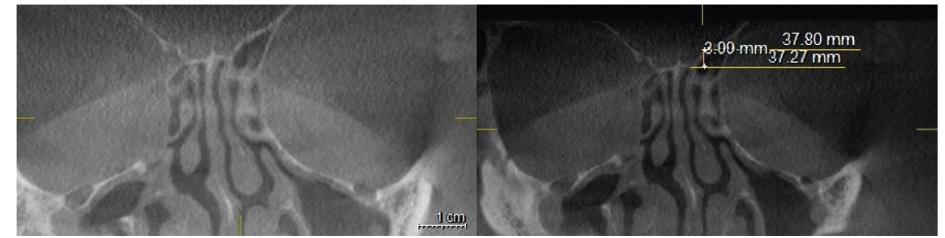
Figure 1: Coronal plan of CBCT demonstrating type 1 Keros classification on the left side.